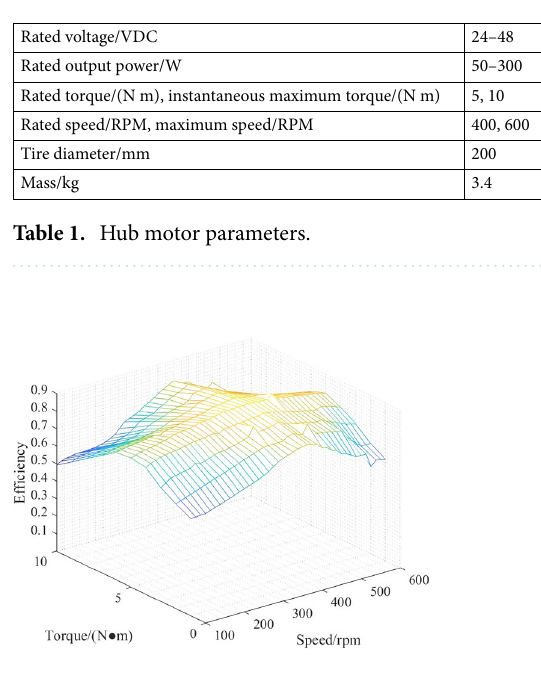
Figure 2. Efficiency characteristics of structure the hub